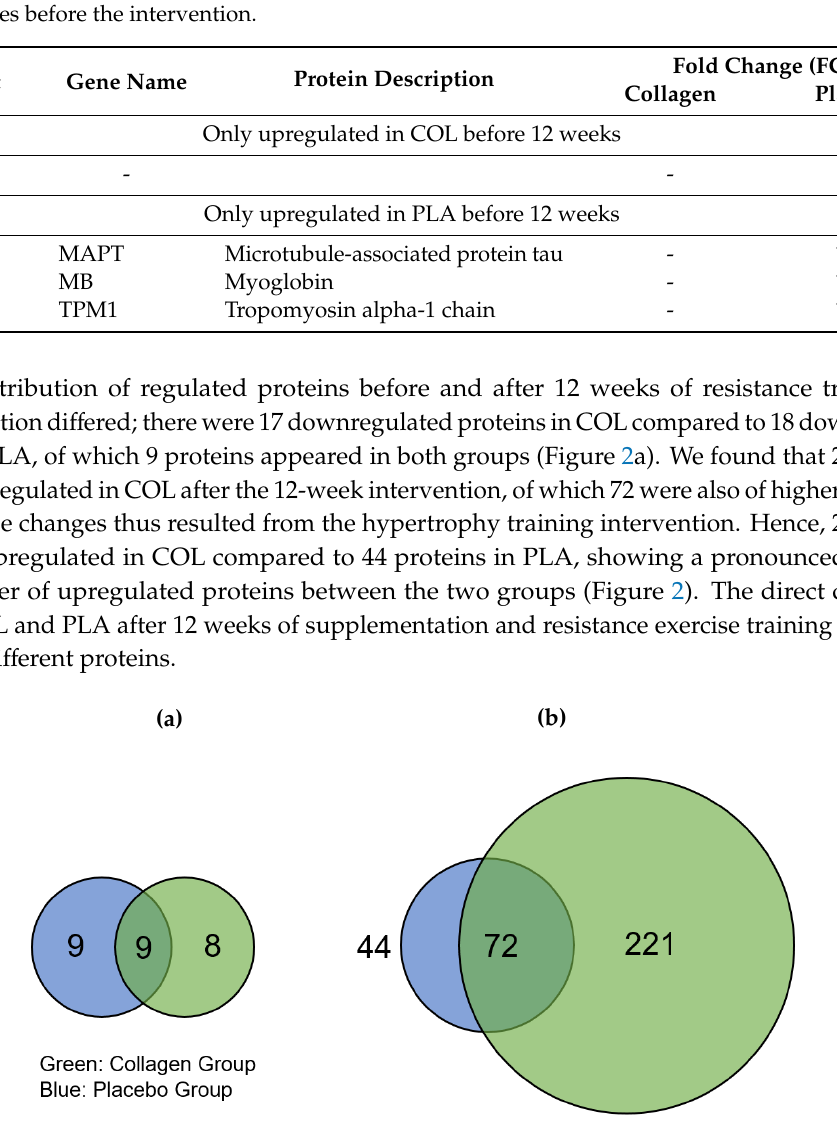
Figure 2. Venn diagrams showing different numbers of ( a ) significantly downregulated and ( b ) upregulated proteins in the placebo (blue) and collagen (green) groups after 12-week resistance exercise training and supplementation. The intersection represents proteins that were regulated in both groups.